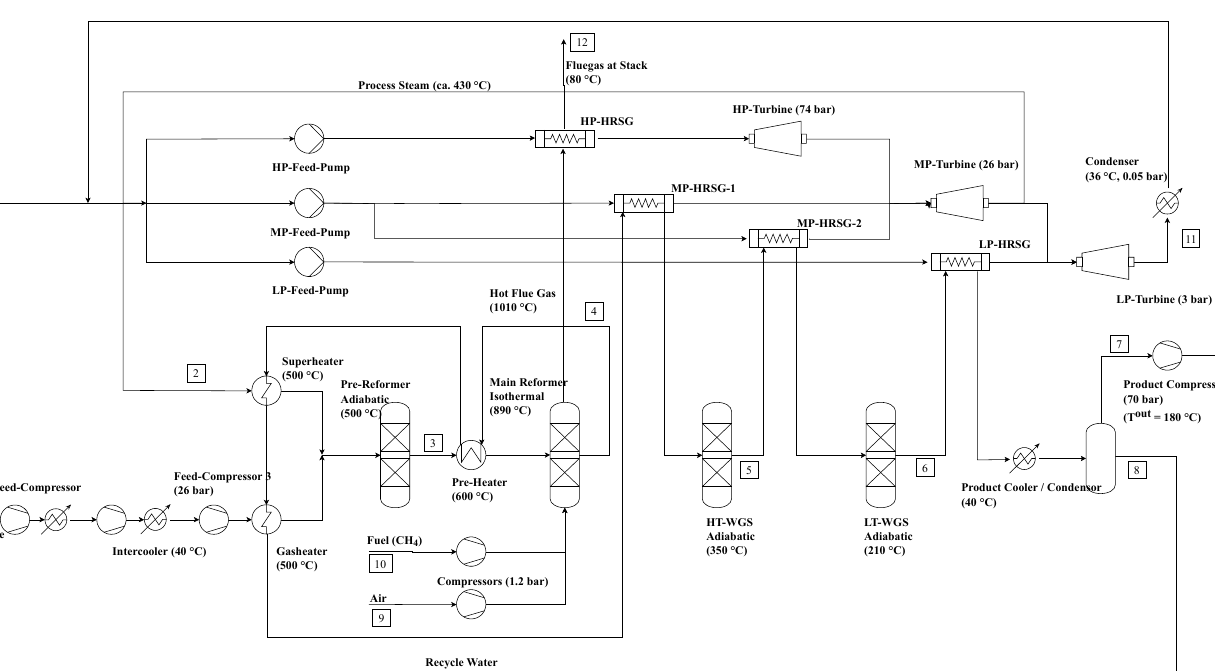
Table 1. Calculated U-Values for different heat exchanger in SMR X95 case.